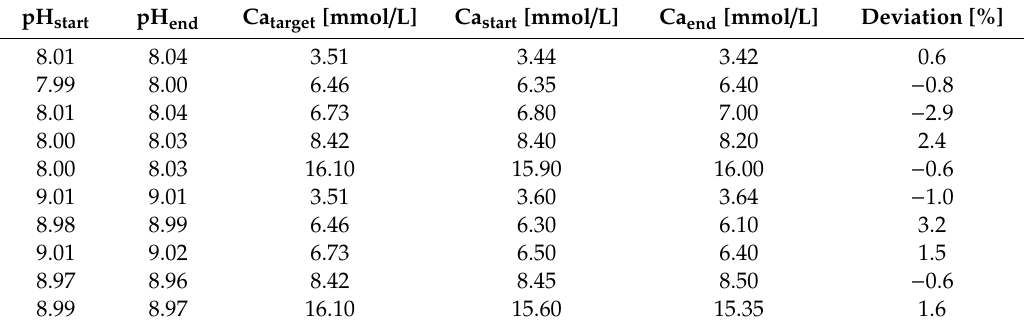
Table 6. Change in calcium concentration in the absence of phosphonates (T = 20 ◦ C; pH = 8 and 9; t c = 7 d; no GFH added). Ca target : target starting concentration, Ca start : actual starting concentration, Ca end : final concentration, Deviation: Ca start / Ca end